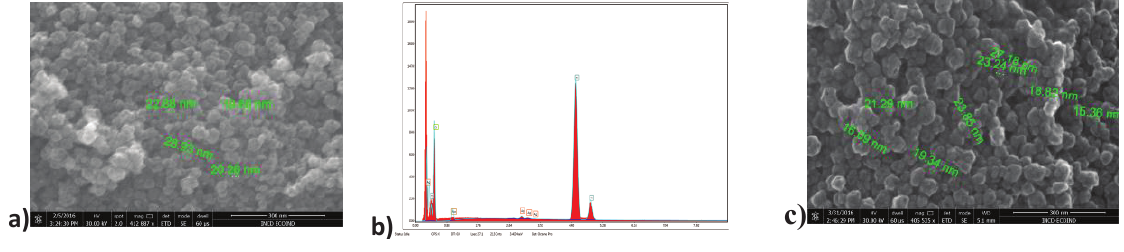
NPs powders and leather surfaces covered with NPs. 2